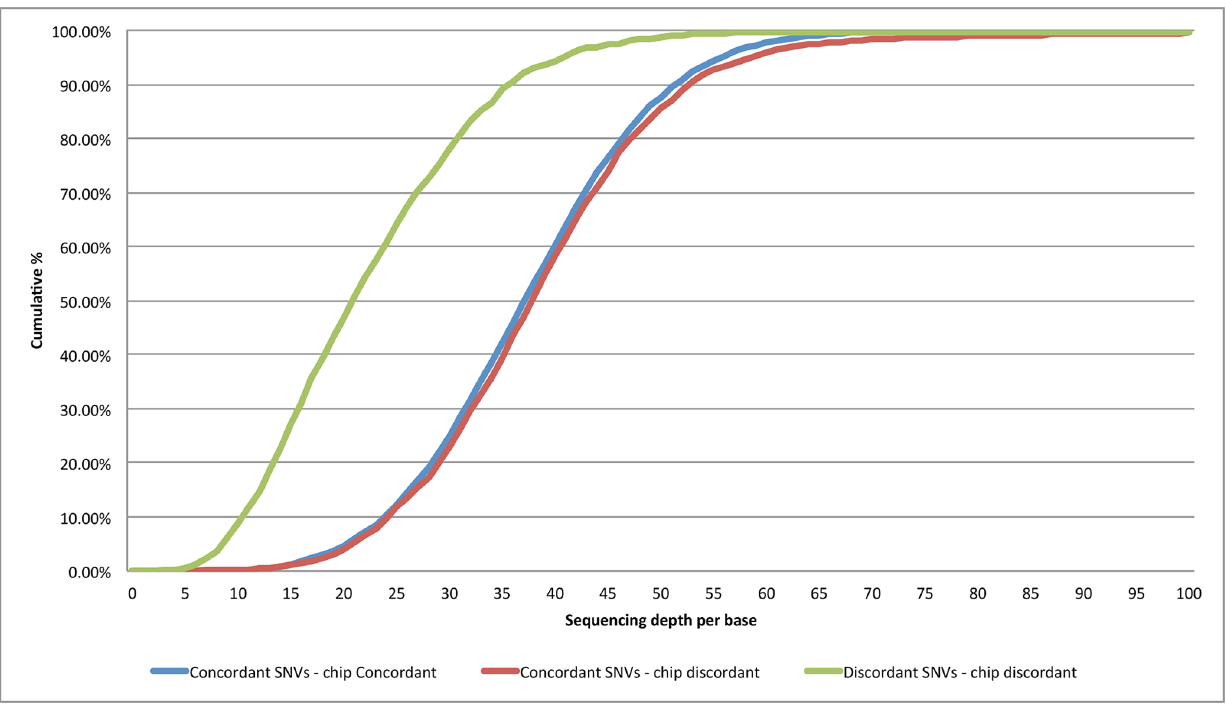
Figure 2. Cumulative frequency plot of sequencing depths in heterozygous calls. The sequencing depths of heterozygous calls in the SOLiD data are plotted. The patterns of concordant SNVs that are either chip-concordant or chip-discordant are almost compatible, which explains why the majority of heterozygous concordant SNVs that are chip-concordant are highly confident calls. In contrast, the median of discordant SNVs that are chip-discordant is substantially lower than those of concordant SNVs, which explains why only 25% of them are highly confident